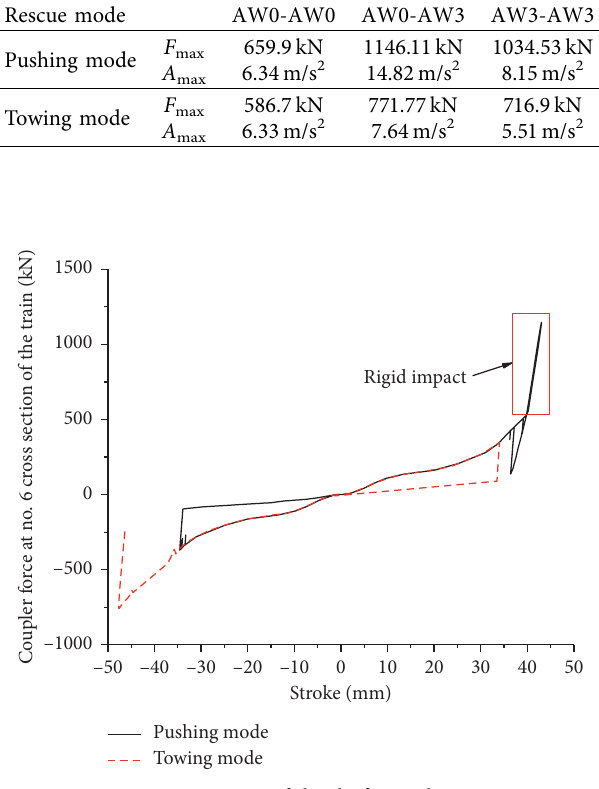
Figure 7: Dynamic response of the draft gear between two trains (AW0 rescues